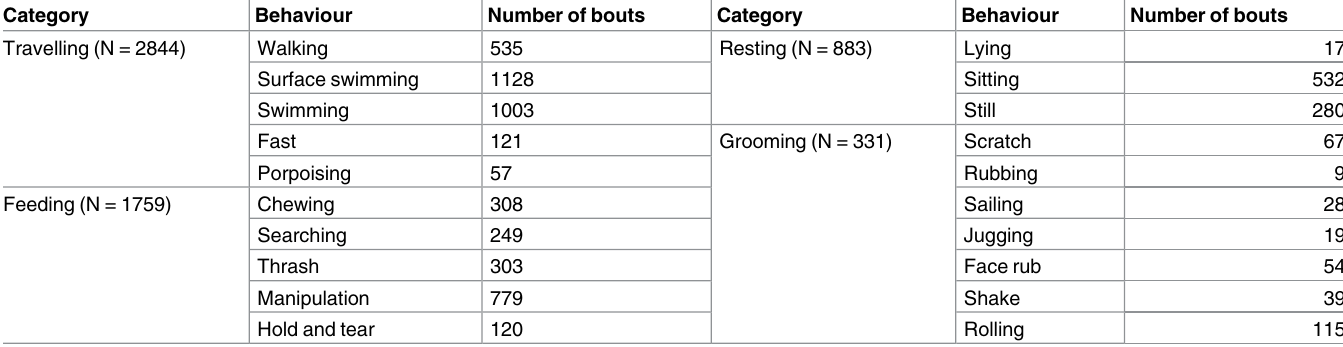
Table 2. Number of bouts of behaviours classified and their associatedcategories.